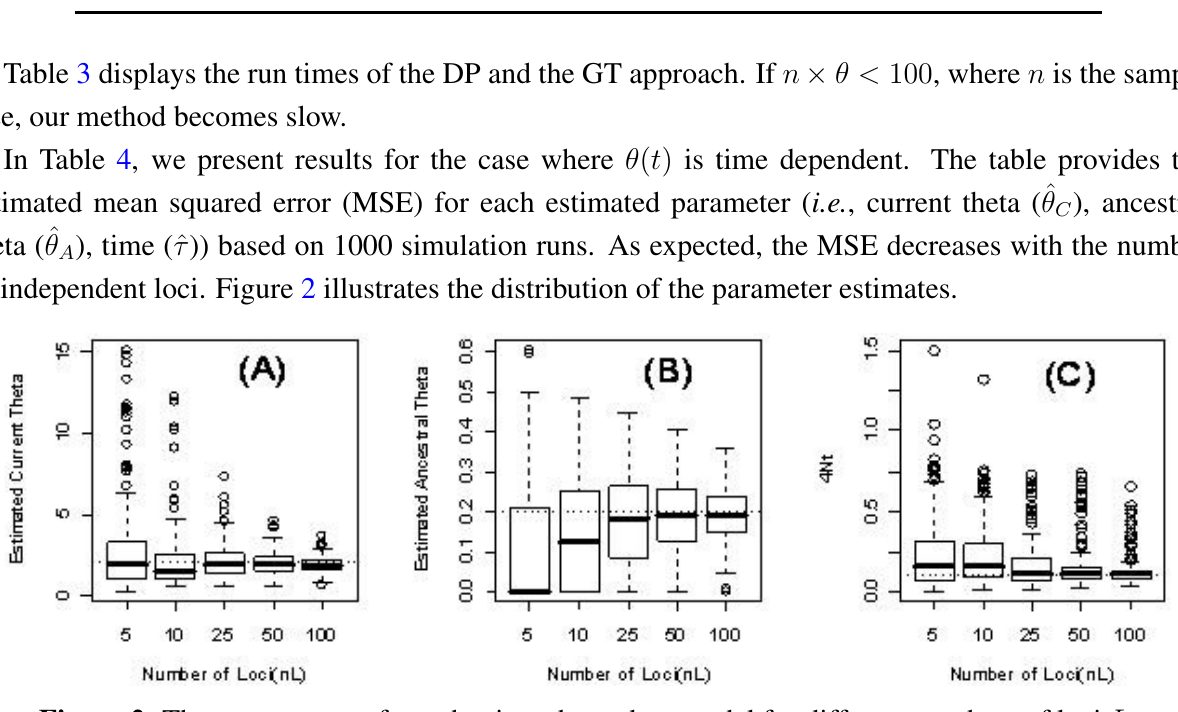
Figure 2. Three parameters from the time-dependent model for different numbers of loci L : 5, 10, 25, 50, 100. ( a ) The estimated current scaled mutation rate ˆ θ ; ( b ) The estimated C ancestral scaled mutation rate ˆ θ ; ( c ) The estimated time ˆ t in units of four times the A (effective) population size 4 N